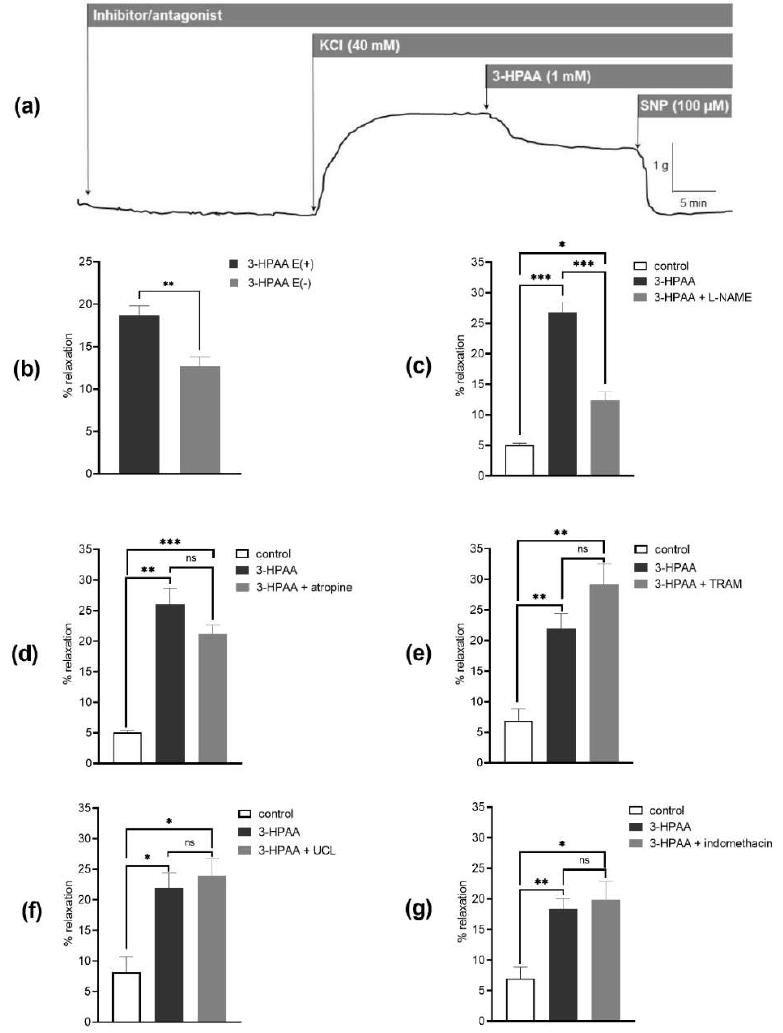
Figure 6. Impact of endothelium and different inhibitors/antagonists on the vasodilatory effect of 3-hydroxyphenylacetic acid (3-HPAA). Scheme of the representative isometric tension traces of the porcine coronary arterial rings ( a ). Ex vivo vasodilatory effects of 3-HPAA (1 mM) were evaluated on endothelium-intact E(+) and endothelium-denuded E( − ) porcine coronary arterial rings precontracted with KCl (40 mM) ( b ). In another experiment set, intact coronary rings were used and the percentage of relaxation was evaluated in the presence of: NO-synthase inhibitor L-NAME (100 µ M) ( c ), or the M-receptor antagonist atropine (50 µ M) ( d ), or Ca 2+ -activated K + channel inhibitors, TRAM-34 (10 µ M) ( e ), or UCL-1684 (1 µ M) ( f ), or the cyclooxygenase inhibitor indomethacin (10 µ M) ( g ). Data were calculated from the maximal relaxation induced by sodium nitroprusside (100 µ M). Significant change: * p < 0.05, ** p < 0.01, *** p < 0.001 ( n = 6, for control n = 4), ns—not